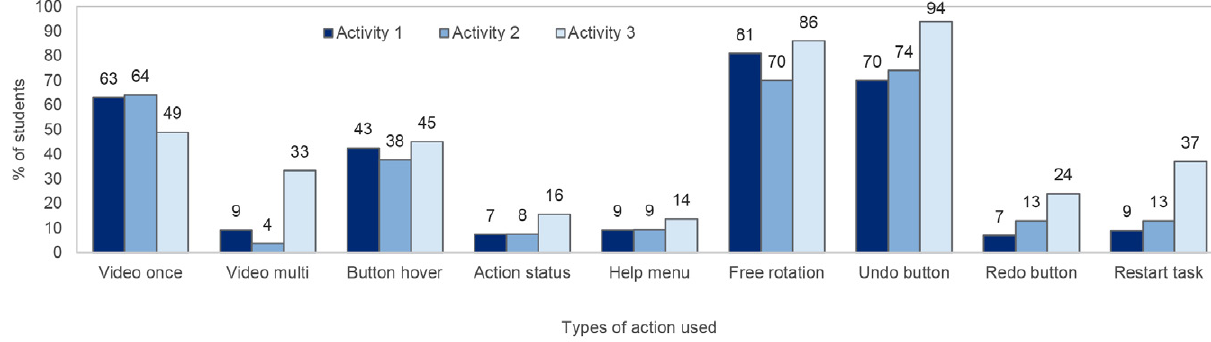
Figure 8: Distribution of actions with help tools by